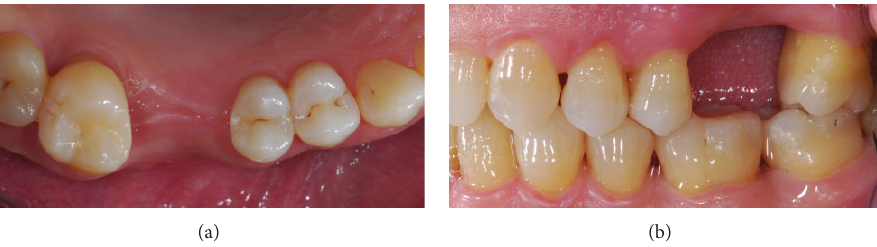
Figure 1: (a) Intraoral occlusal view of edentulous area before treatment. (b) Intraoral lateral view of tooth gap; the interabutment distance measured was 11mm.